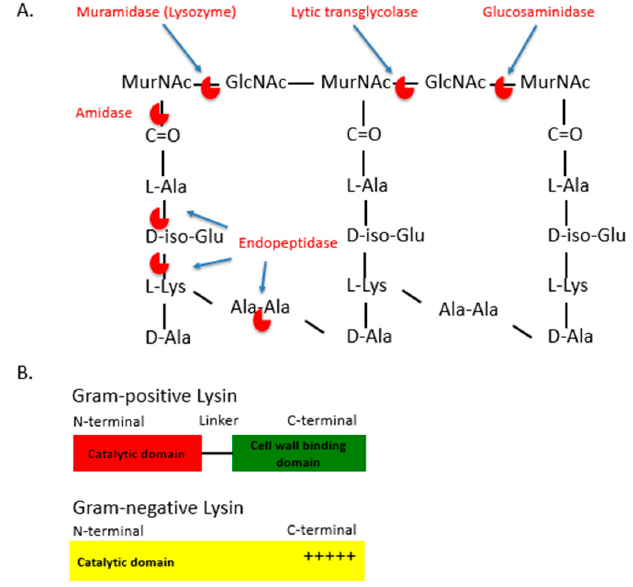
Figure 1. Structure and function of lysins. ( A ). Categories of lytic enzymes. Lytic enzymes are categorized based on the type of the chemical bond that is cleaved within the peptidoglycan layer. 1. Amidases hydrolyse the bonds between the sugar and the stem peptide moieties. 2. Endopeptidases cleave the bonds between amino acids of the stem peptides and the interpeptide bridges. Glycosidases, are subdivided into lysozymes or muramidases, lytic transglycosylases and glucosaminidases. Muramidases hydrolyse while lytic transglycolases cleave the same glycosidic bonds between the alternating MurNAc and GlcNAc disaccharide backbone. Glucosaminidases cleave glycosidic bonds between the GlcNAc and adjacent MurNAc monosaccharide in the glycan strand. ( B ). The schematic structure of a Gram-positive and a Gram-negative lysins.